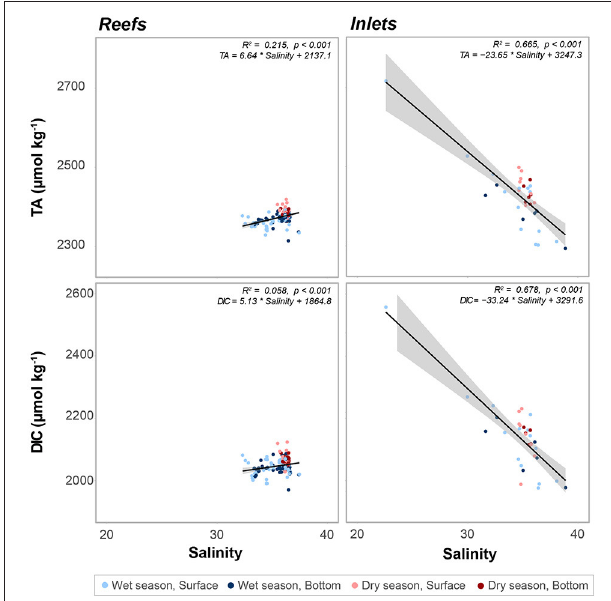
FIGURE 5 | Linear regression of total alkalinity (TA, µ mol kg − 1 ) as a function of salinity at reef and inlet sites. Error bars in gray, R 2 and p values, as well as the equation for each fitted line given for each sampling site. Data are divided into dry (red) and wet season (blue). Darker colors represent samples taken above the benthos while lighter colors represent samples taken at the